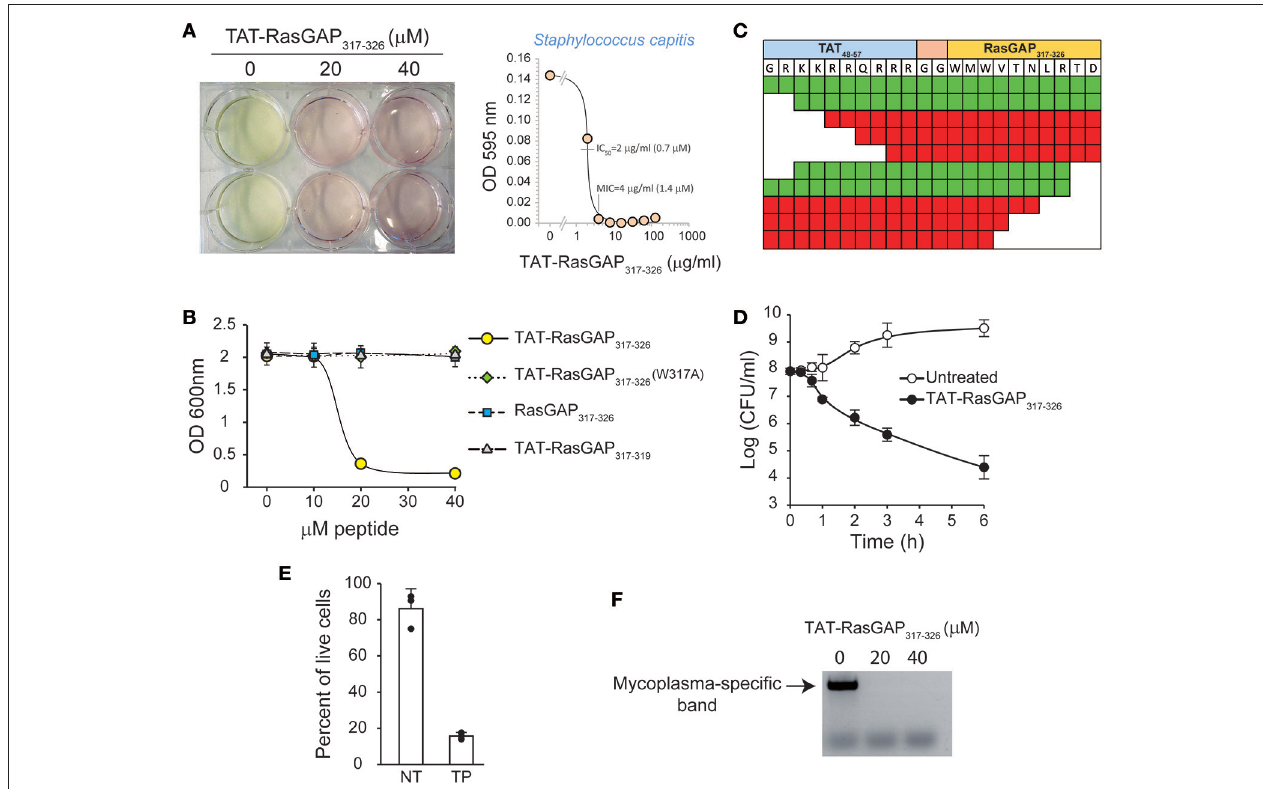
FIGURE 1 | TAT-RasGAP 317 − 326 , but not mutated or truncated forms, has antimicrobial activities. (A) Contaminated U2OS cell cultures treated or not with 20 µ M TAT-RasGAP 317 − 326 . Please observe the yellow color due to lower pH in presence of the growing contaminant. The contaminant was identified as Staphylococcus capitis . The panel on the right shows the sensitivity of this isolate to the peptide. The bacteria were grown in the presence of the indicated concentrations of TAT-RasGAP 317 − 326 . The OD 595 nm was measured after 16 h of incubation at 37 ◦ C. IC 50 , fifty percent maximal inhibitory concentration; MIC, Minimal inhibitory concentration. (B) E. coli DH5 α [optical density (OD) 600nm of 0.25] were incubated for 7 h at 37 ◦ C with the indicated concentrations of WT, mutated (W317A), or truncated TAT-RasGAP 317 − 326 (RasGAP 317 − 326 and TAT-RasGAP 317 − 319 ) peptides. The OD 600 nm was then measured. The results correspond to the mean ± 95% CI of three independent experiments. (C) E. coli DH5 α (OD 600 nm of 0.25) were treated with 30 µ M of different truncated versions of TAT-RasGAP 317 − 326